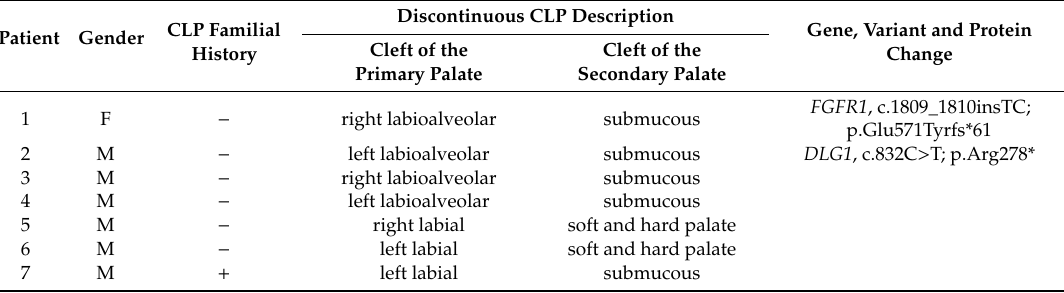
Table 1. Summary of